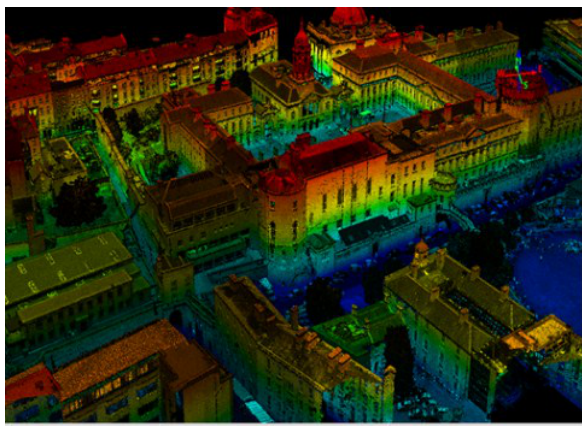
Figure 7: Sample of Aerial Laser and Photogrammetry Survey of Dublin Historic